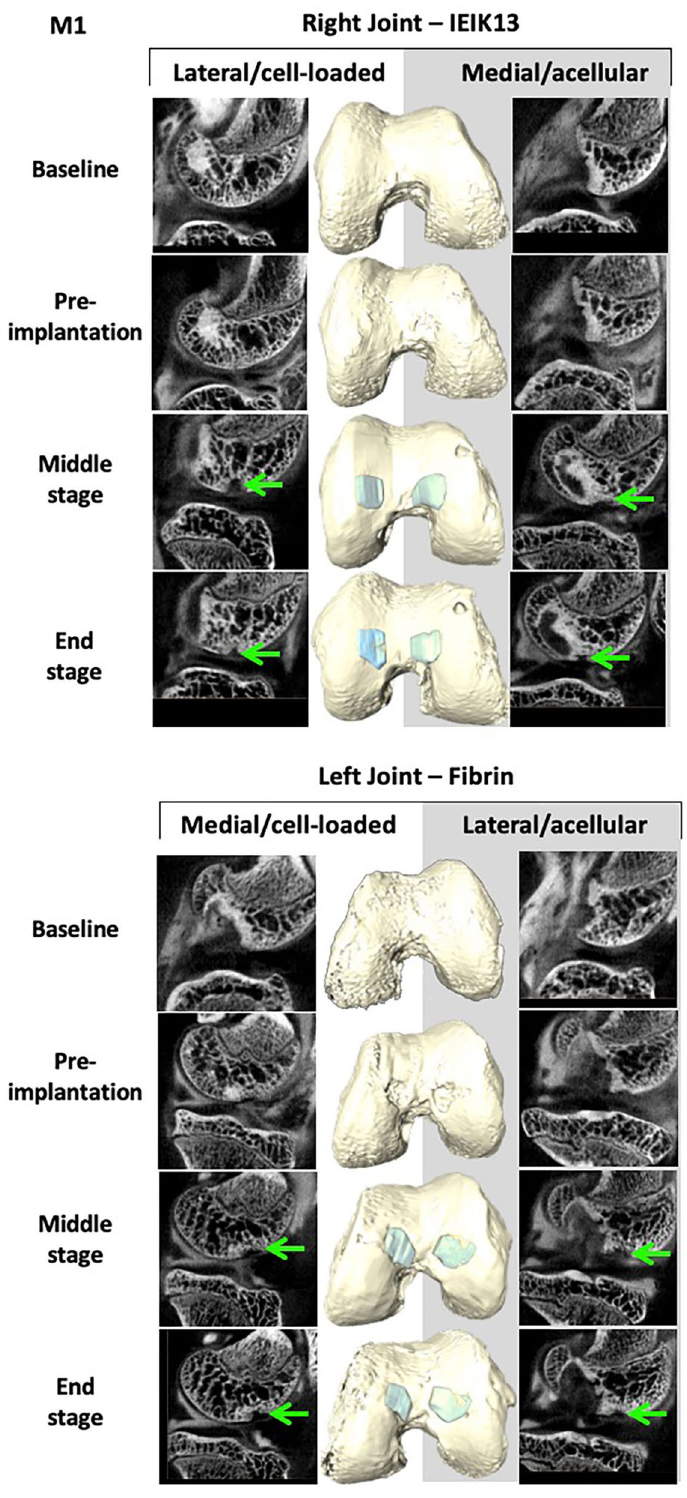
Figure 4. Non-invasive monitoring of IEIK13- and fibrin-based hydrogels implanted in M1 monkey. The hydrogels were loaded or not with cells, as indicated. The site of implantation in knee joint is specified. Examples of segmented CECT images (left and right panels) and 3D surface reconstruction (middle panel) corresponding to different stages of the study: 3 days before first surgery (baseline), 6 days before removal of the scar tissue and implantation (pre-implantation), 41 days after implantation (middle-stage) and 82 days after implantation (end- stage). The green arrows show absence of contrast agent, indicating occupancy of the corresponding regions by the